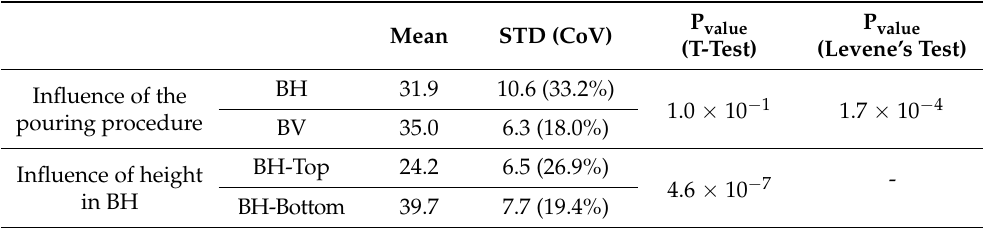
Table 4. Statistical parameters that influence the pouring procedure’s influence on the fibre amount distribution.